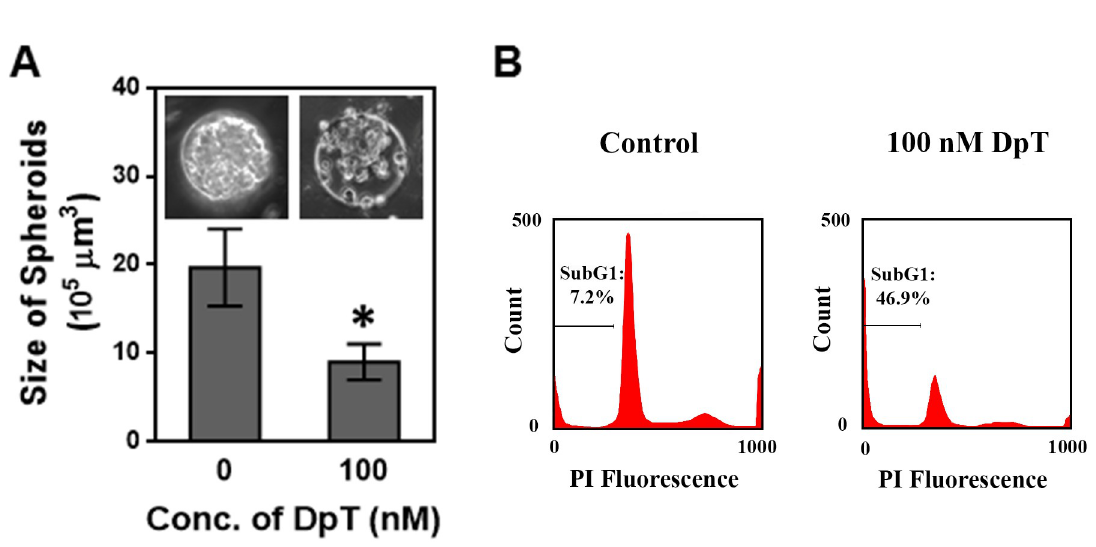
Fig 6. Effect of an anti-tumor agent Dp44mT on U251 spheroids. A) Bar graph shows the volume of glioma spheroids upon exposure to 0 nM Dp44mT (control) and 100 nM Dp44mT for five days. Data points represent the mean of 10 independent experiments and error bars represent SD. � represents P < 0.01 vs. control (0 nM). The inset shows phase contrast images of the control and Dp44mT-treated spheroids. Sale bar represents 50 μ m. B) Flow cytometry data demonstrate the sub-G1 population (i.e. apoptotic cell population) in control and Dp44mT-treated (100 nM)